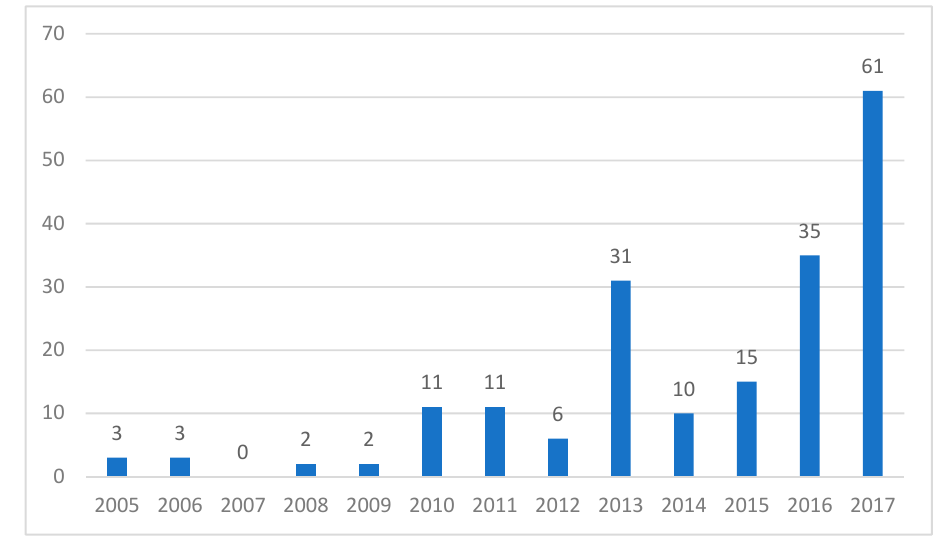
Figure 1. Evolution over time.